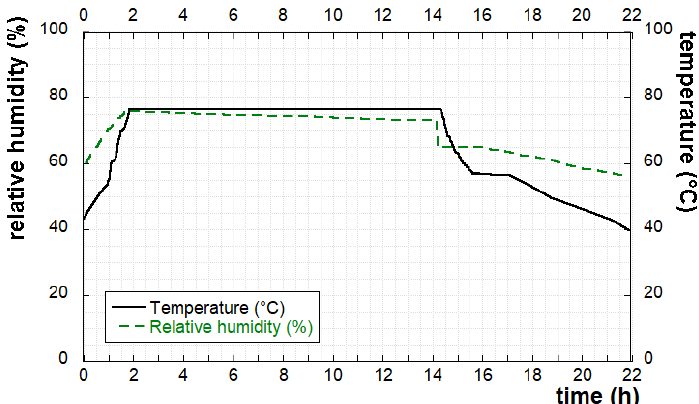
Figure 1. Pasta drying diagram: relative humidity and temperature vs. time.